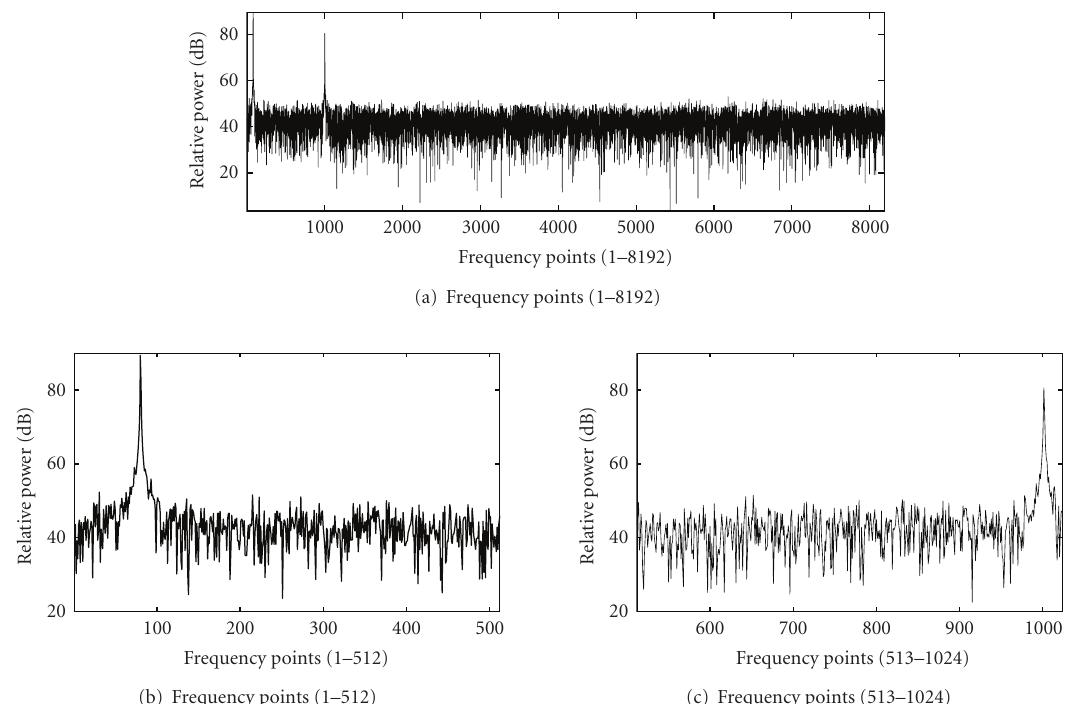
Figure 4: Spectrum of processing results with proposed method.